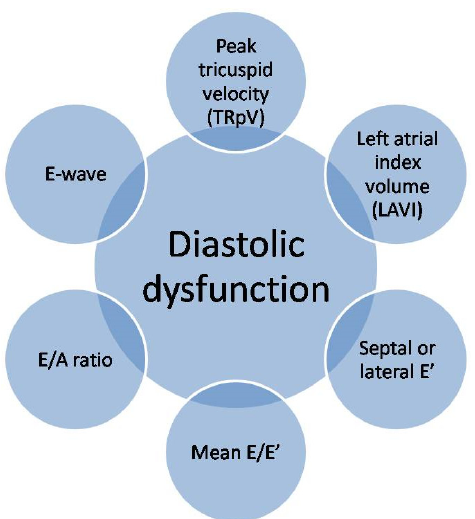
Figure 3. Echocardiographic assessment of left ventricular diastolic dysfunction.